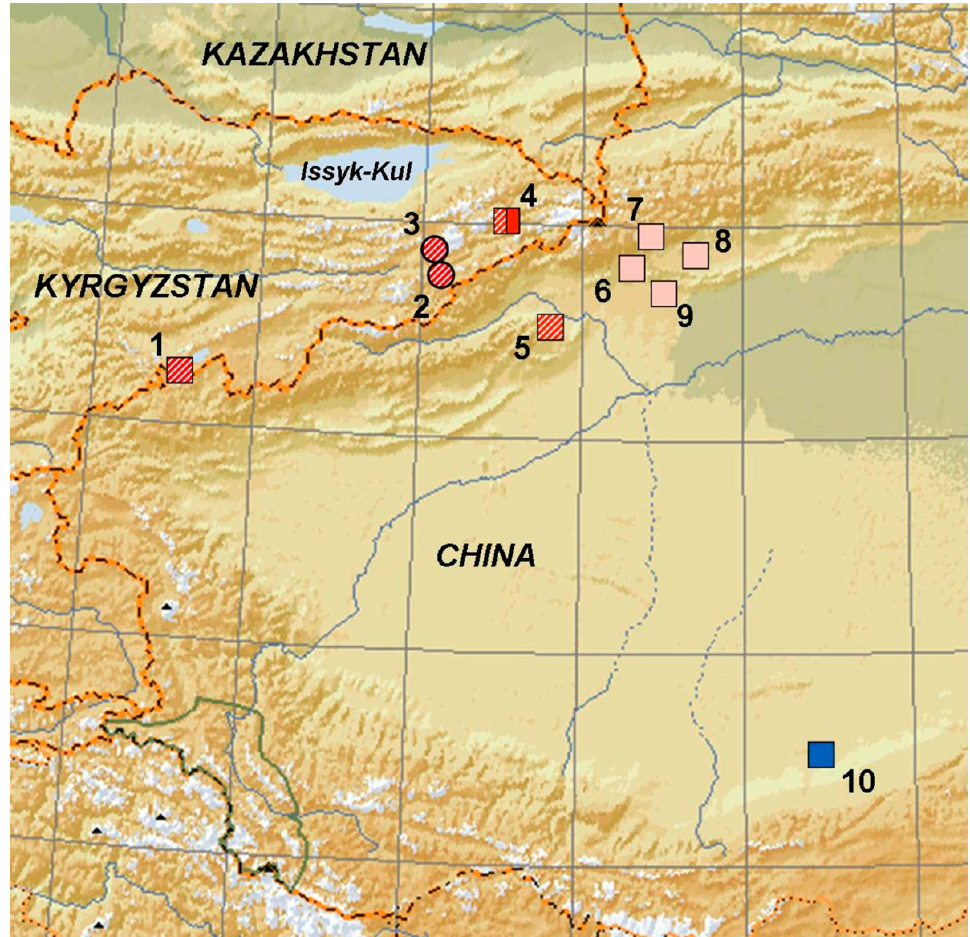
Figure 1. Sites of examined specimen of Eremias kokshaaliensis (red) and E. buechneri (blue). Kyrgyzstan: 1—border with China, Xinjiang, Kara-Teke (ZISP 8277); 2—Bedel valley (ZISP 8291); 3—southern Tien Shan (ZISP 8292); 4—Sary-Dhaz, vicinity of Engylchek (Enylchek (BSI R000587–591, 599–601 and ZMMU R-3302; China: 5—Taushkan–Darya (ZISP 8289); 6–60 km northeast of Aksu city, east spurs of Pobeda Peak Mountain (ZMMU 14329); 7—75 km northeast of Aksu city (ZMMU 14330); 8—9 km northeast of Aksu city, east spurs of Pobeda Peak Mountain (ZMMU 14328); 9—5 km northeast of Aksu city, spurs of Talyktau mountain (ZMMU 14327); 10—near Tolan-Khodjha River in Kashgaria (ZISP 9131). Numbers in square correspond to location of the specimens used both in morphological and molecular genetic analysis: solid square; this study: dashed square [14]. Red square corresponds to specimens used in this study; pink square [27]; Figure 1 and Appendix II. Numbers in circle correspond to location of the specimens used in morphological analysis only.